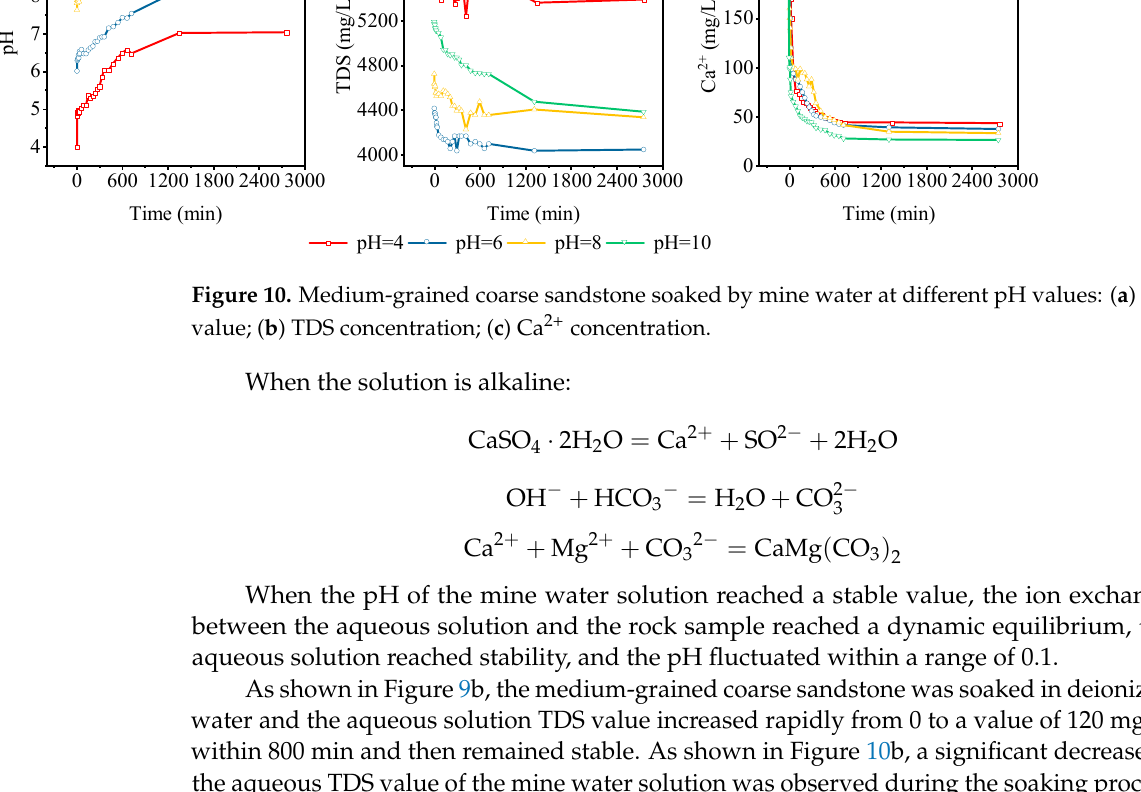
Figure 9. Solution characteristics of medium-grained coarse sandstone after leaching with deionized water: ( a ) pH value; ( b ) TDS concentration; ( c ) Ca 2+ concentration.